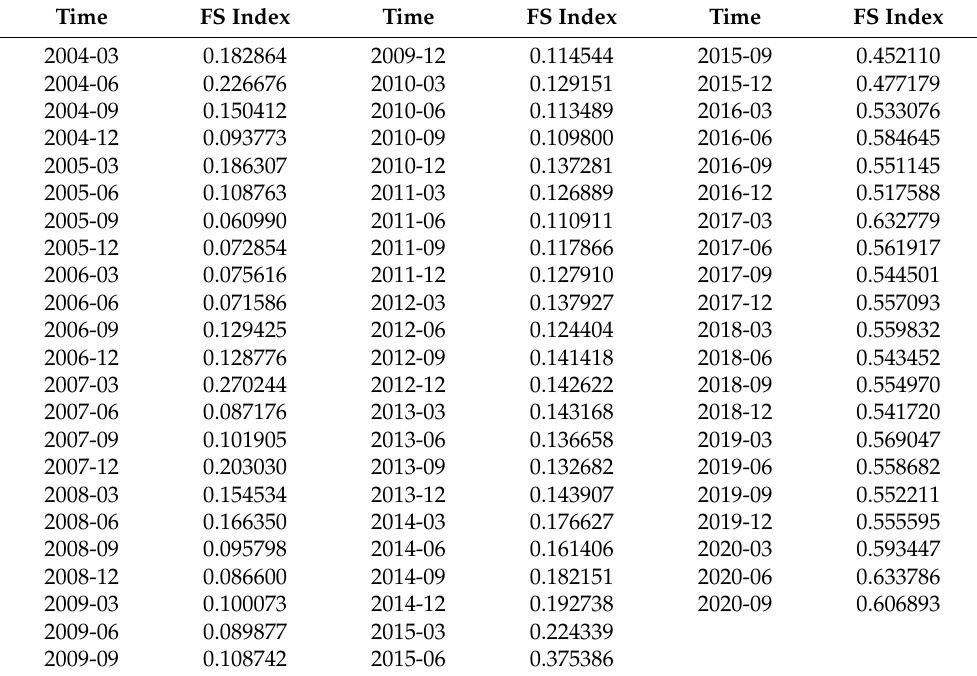
Table 3. China’s finance structure Index (2004–2020). Source: Own calculation based on Equation